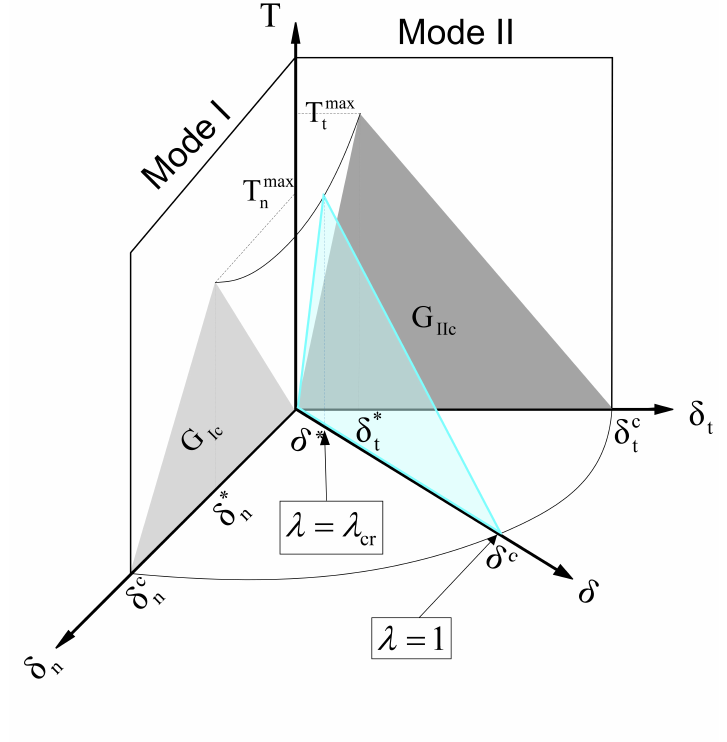
Figure 2. Bilinear mixed mode traction-separation